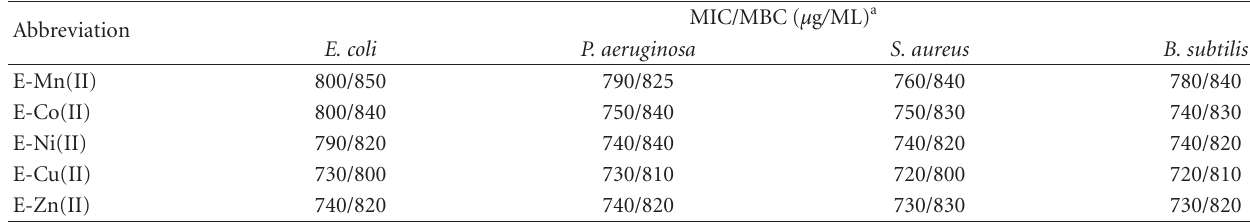
Table 3: Antibacterial activity of metal-chelated epoxy polymers.